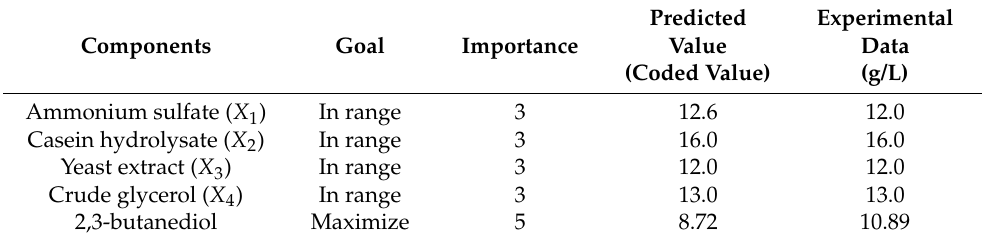
Table 4. Numerical optimization of medium components to maximize 2,3-butanediol production by regression model. Components Goal Importance